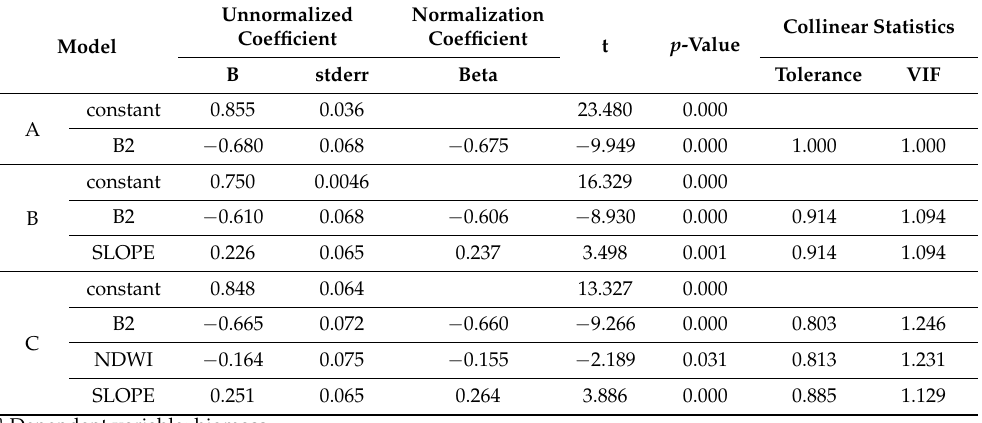
Table 4. Detailed parameter table of the carbon stock estimation model a .